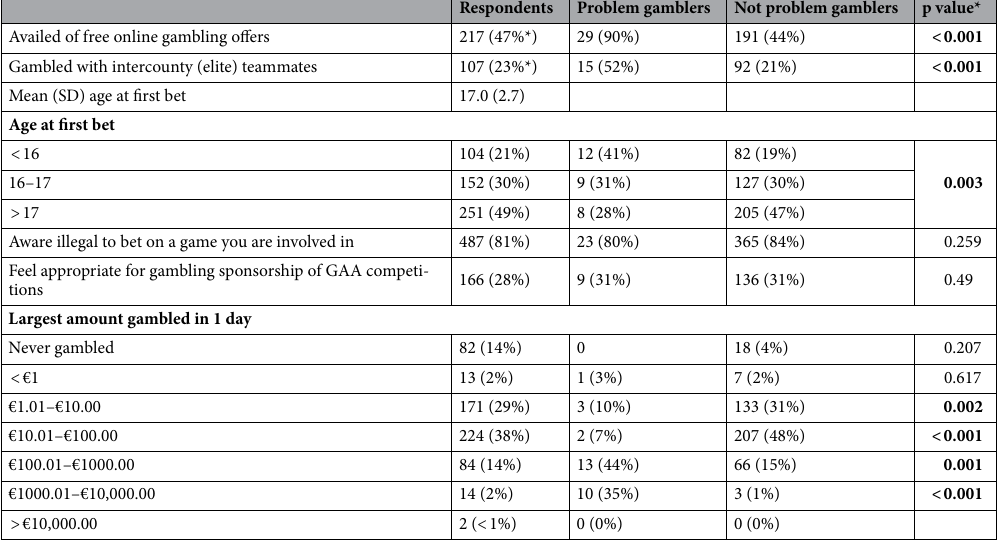
Table 5. Gambling behaviours. *Of current (past year) gamblers. Significant values are in